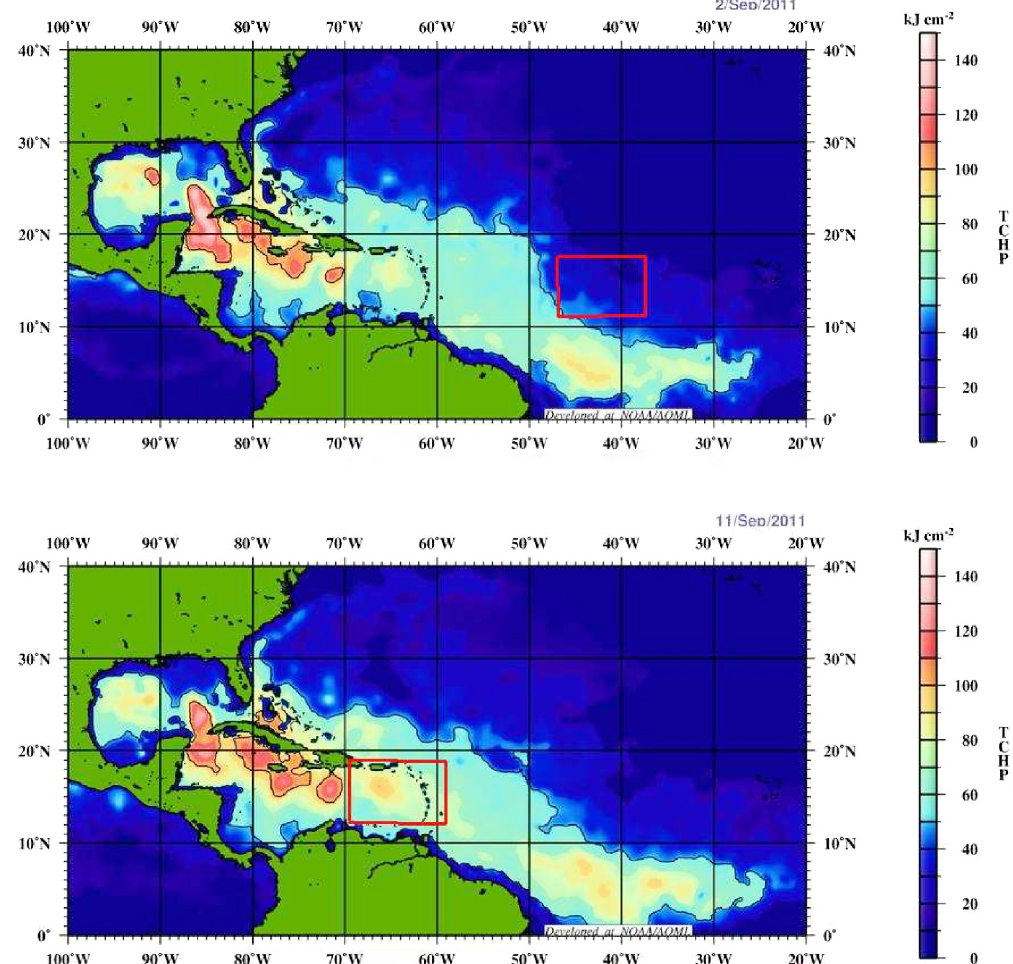
Fig. 9. TCHP for Gaston 1 (top panel) and Karl 3 (bottom panel). The red boxes mark approximately the respective observational areas. The graphics are taken from